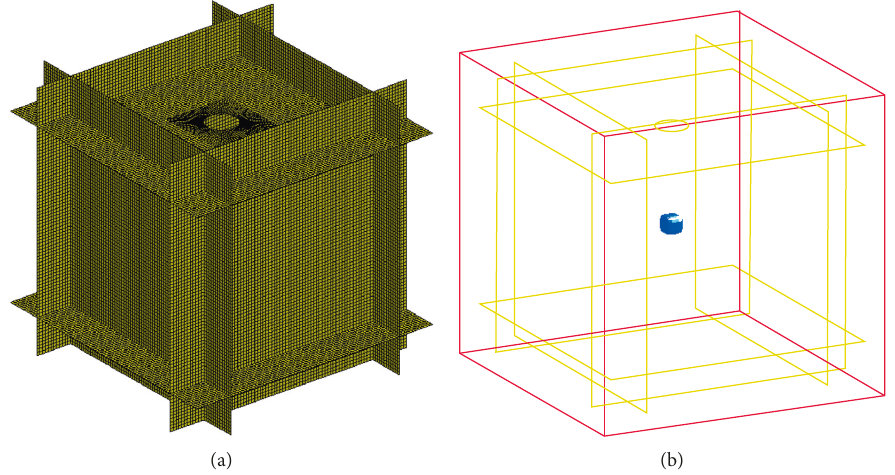
Figure 2: Finite element model. (a) Box model. (b) Air and